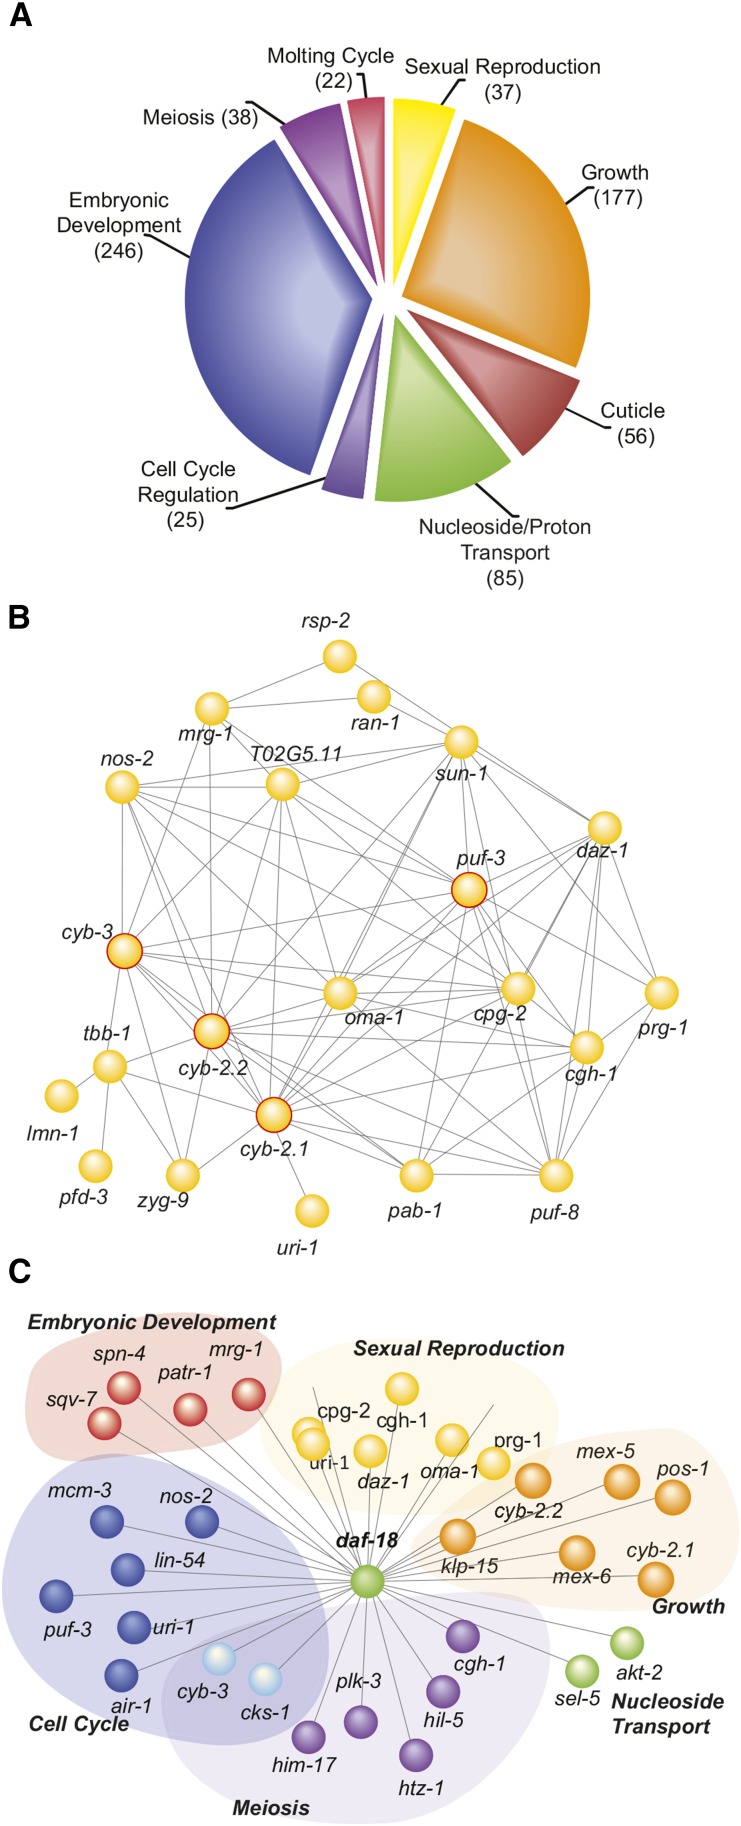
Functional annotation of HLH-25 targets. (A) Distribution of HLH-25 targets into top eight GO clusters. (B) Predicted and known interactions between genes in the ‘sexual reproduction’ cluster. The hub genes cgh-1, cyb-2.1, cyb-2.2, cyb-3, and puf-3 are outlined in red. The hub gene daf-18 is not a part of the ‘sexual reproduction’ cluster. (C) Representative genes from the 62 HLH-25 targets that form predicted or known interactions with daf-18. All genes, except daf-18, clustered under “embryonic development ending in birth (EDB)” Most genes also clustered under at least one other top GO category, including “nucleoside/nucleotide transport” (green spheres).